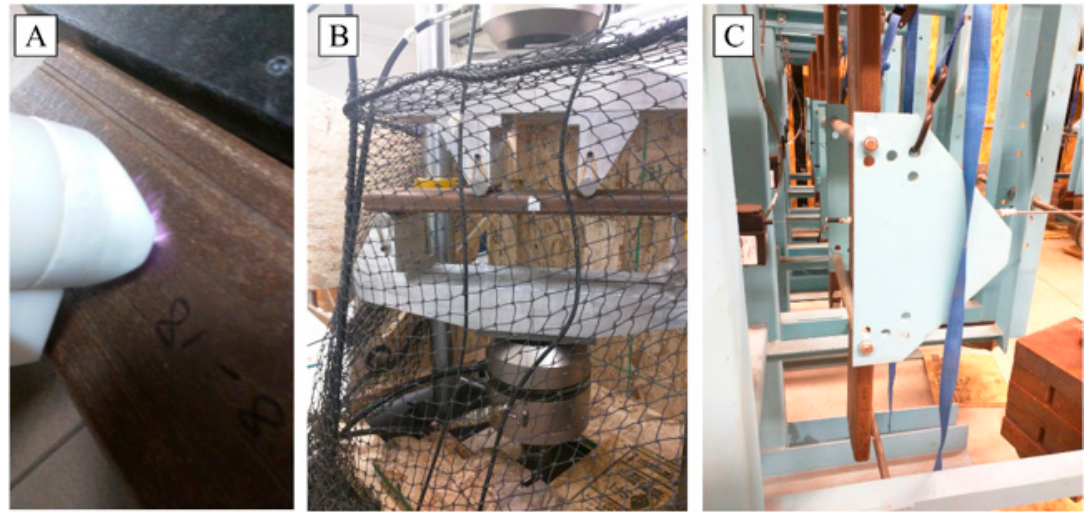
Figure 2. Experimental work. ( A ) Corona treatment prior to adhering the square metal at the midspan of WPC. ( B ) Four-point bending flexure test with L/h ratio of 16 in accordance with ASTM D6109 to obtain the flexural strength and the apparent elastic modulus of WPC lumber. ( C ) Long-term creep WPC specimens, the test setup test rigs, and the WPC specimens with L/h ratio of 25.5.